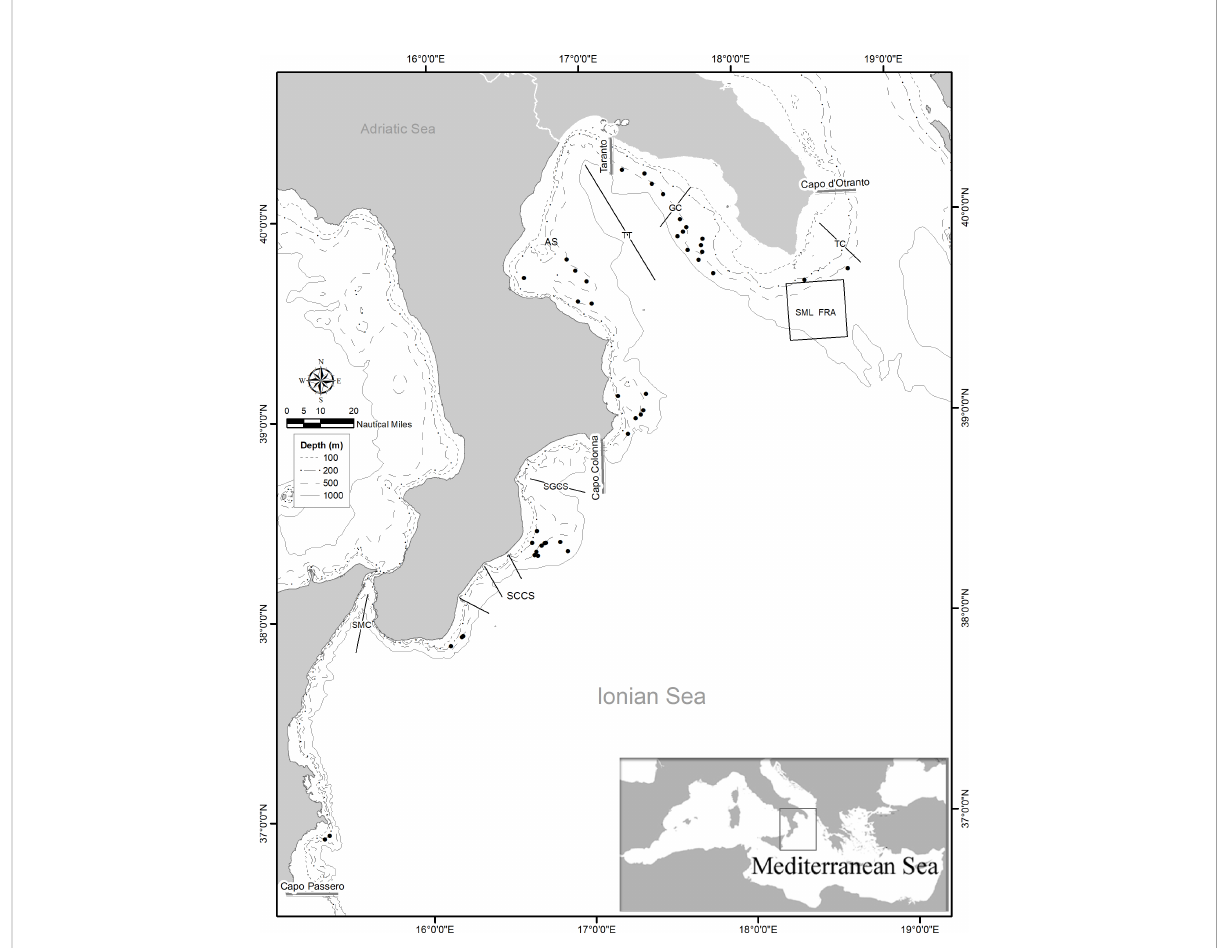
FIGURE 1 Map of the study area in the northwestern Ionian Sea, with indication of the sampling hauls (black circle) performed by year from 2012 to 2020 and topographic features. SML FRA, Santa Maria di Leuca Fisheries Restricted Area; TC, Tricase Canyon; GC, Gallipoli Canyon; TT, Taranto Trench; AS, Amendolara Shoal; SGCS, Squillace Gulf Canyon System; SCCS, South Calabria Canyon System; SMC, Strait of Messina